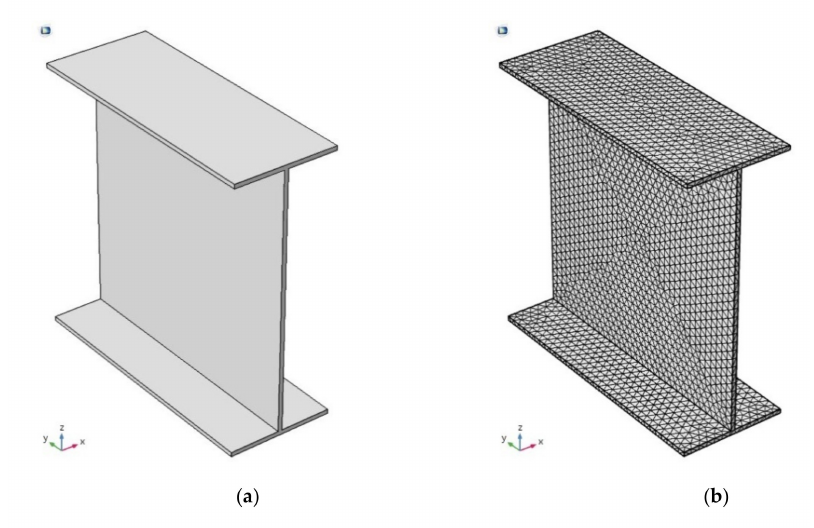
Figure 5. The finite element model of the experimental beam: ( a ) Geometry; ( b )